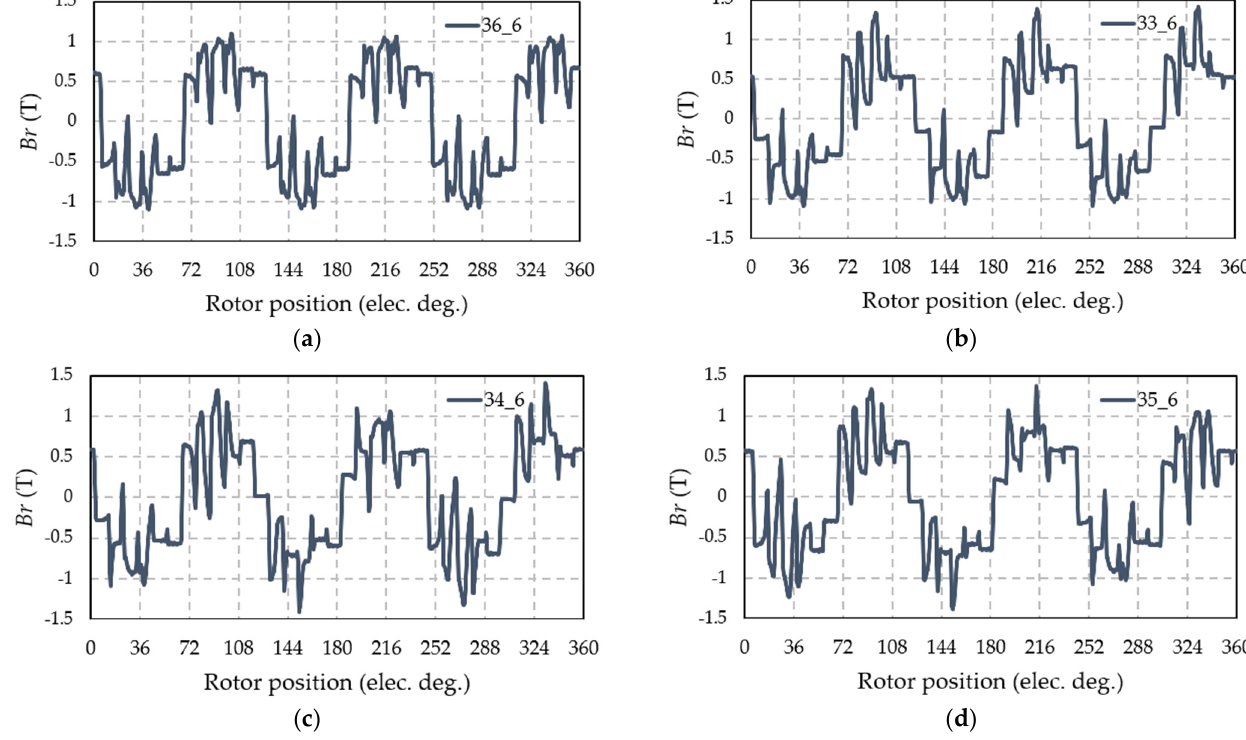
Figure 7. Air − gap flux density waveforms of four motors with two − layer flux barrier and PM: ( a ) M 1 : 36 − slot and 6 − pole; ( b ) M 2 : 33 − slot and 6 − pole; ( c ) M 3 : 34 − slot and 6 − pole; ( d ) M 4 : 35 − slot and 6 − pole.